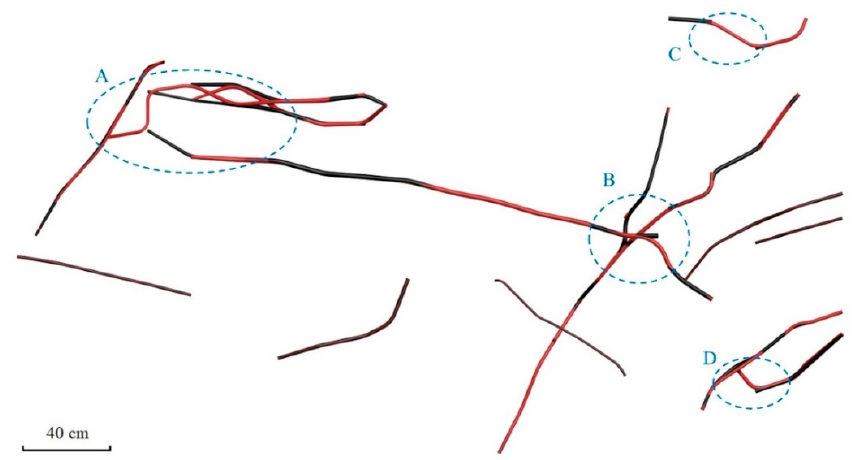
Figure 14. Comparison between the actual measured (black) and reconstructed (red) 3D root system architecture (RSA) as seen from the ground plan view. Blue dashed circles A–D represent four major differences between the measured and reconstructed RSA.